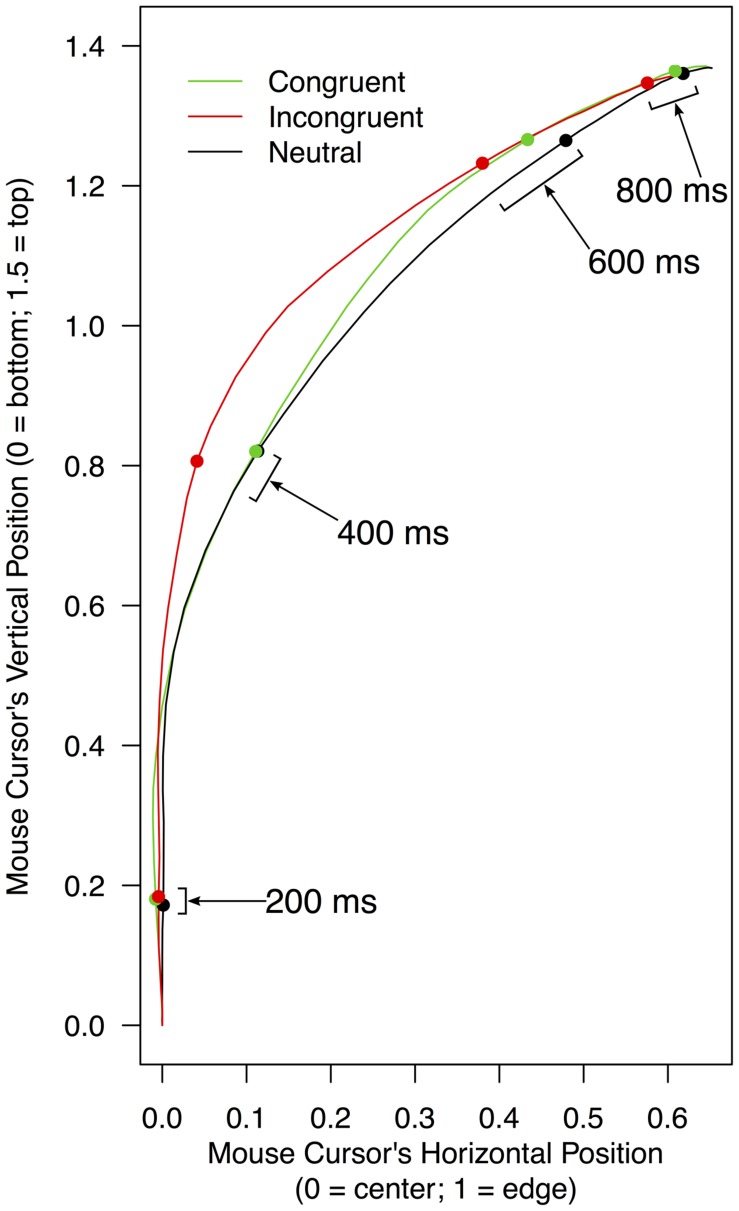
Mean trajectories of a mouse cursor on a screen as a function of experimental conditions. To compute these mean trajectories, leftward trajectories were bilaterally flipped and pooled with rightward trajectories (for details, see section “Mouse Trajectory” under “RESULTS” of the text). Filled dots indicate mean mouse positions in each condition for every 200 ms since the beginning of a trial.